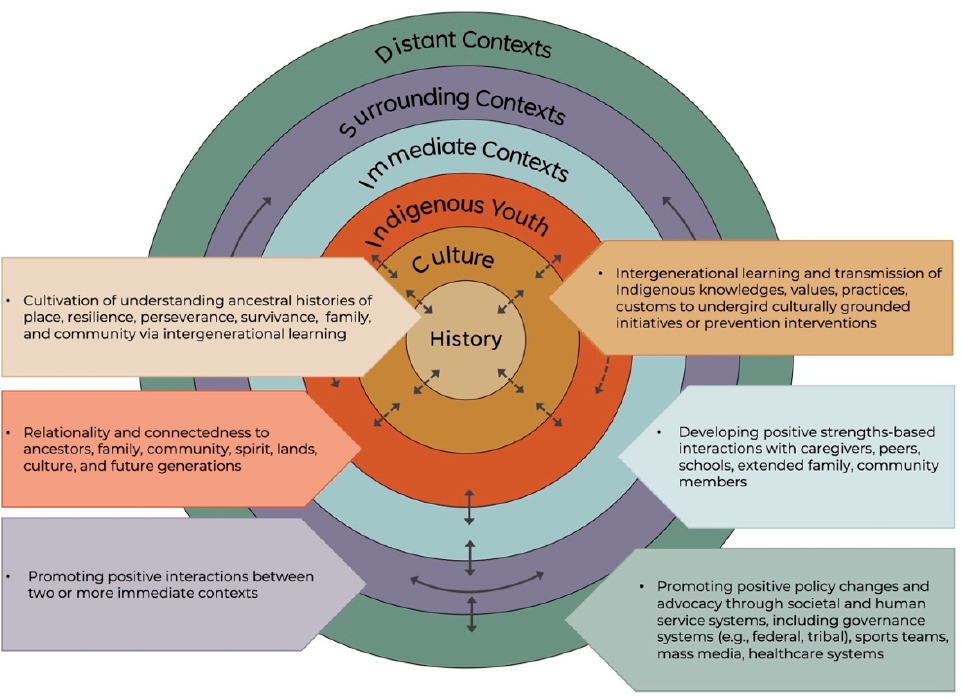
Figure 2. Indigenist Ecological Systems Model. Adapted with permission from [14,17].